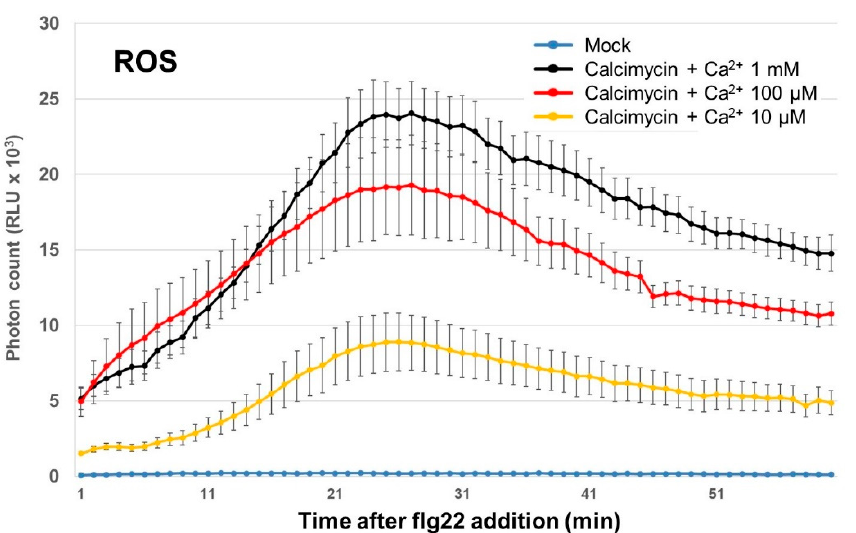
Figure 2. Direct effect of increased cytosolic calcium on apoplastic ROS signaling under exposure to a calcium ionophore. Line graph shows the effects of adding calcium (as 10 µM, 100 µM, or 1 mM of CaCl 2 ) after incubation with the calcium ionophore calcimycin (100 µM) on apoplastic ROS production. Note that ROS productions are raised by addition of calcium in a dose-dependent manner.